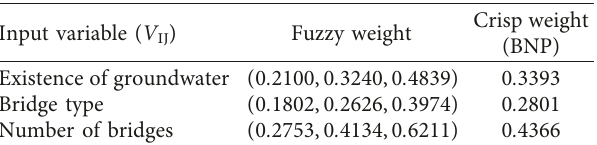
Crisp weight (BNP)